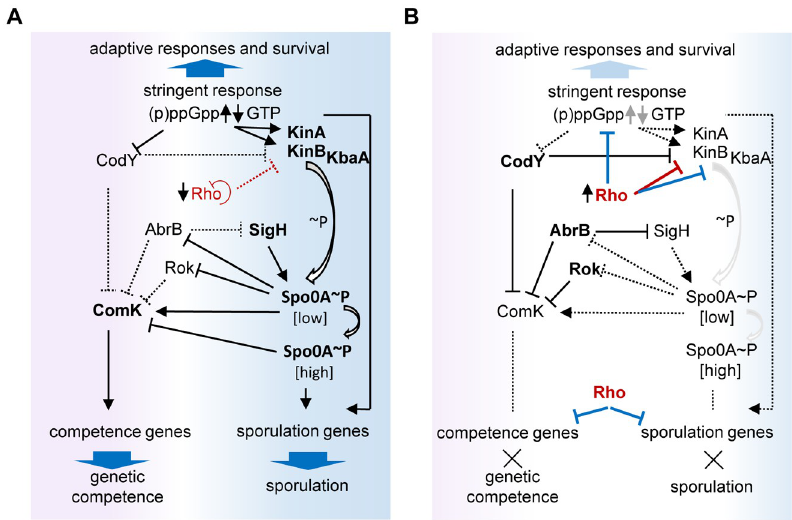
Fig 10. Tentative model integrating the termination factor Rho into the regulatory networks controlling the adaptation to stationary phase and the programs of genetic competence and sporulation in B . subtilis . For simplicity, only the key elements relevant to this study are shown, and the discussion of the regulatory activities of CodY and AbrB is limited to the comK gene. The arrowhead lines and bar-headed lines indicate positive and negative regulation, respectively. Solid and dashed headed lines indicate strong and weakened regulation, respectively, and the dashed lines without extremities stand for the loss of positive regulation. Red and blue bar-headed lines depict the Rho- mediated negative regulatory events identified previously (red) and in this study (blue). ( A ) In B . subtilis cells grown under starvation conditions, the increased (p)ppGpp synthesis linked to the activation of stringent response leads to lowering of GTP levels, thus decreasing the activity of CodY and stimulating the expression of the kinA and kinB genes, which are under positive stringent control [112]. The major sensor protein kinases KinA and KinB initiate transfer of the phosphoryl groups to Spo0A. KbaA protein stimulates KinB activity. The gradual increase in Spo0A * P activates expression of comK directly and indirectly by relieving the Rok- and AbrB-mediated repression of comK . By repressing AbrB, Spo0A~P activates the expression of sigH , thus creating a positive feed-back loop of autoregulation [37,79].When concentration of Spo0A~P reaches a high threshold level, it represses comK and activates expression of early sporulation genes. Synthesis of (p)ppGpp is necessary throughout the entire sporulation pathway [126]. In starving cells, Rho levels decrease due to the negative autoregulation [72] and some unknown regulatory circuits. Lowering of the Rho levels decreases the efficiency of the Rho-controlled transcription terminators thus activating, directly and indirectly, transcription of a set of genes and ncRNAs involved in adaptation to stationary phase. In particular, the lowering of Rho weakens the activity of the kinB intragenic Rho-dependent transcription terminator; as a result, the intensified read-through at the terminator stimulates synthesis of the full-length kinB transcript and consequently the activity of Spo0A~P [26]. ( B ) Counteracting the natural decrease of Rho levels by rho over-expression alters the normal progression to stationary phase as depicted. Stabilization of the intracellular levels of Rho in the stationary Rho + cells improves the Rho-dependent transcription termination and consequently alters the expression of the Rho-controlled genes and ncRNAs. A high Rho inhibits read-through at the intragenic transcription terminators of kinB and the newly identified Rho target kbaA gene thus decreasing the full-gene transcription of kinB and kbaA . A decreased flux of the phosphate alters the Spo0A~P-mediated inhibition of AbrB and thus disrupts its positive autoregulatory loop. As a result, Spo0A~P does not reach the threshold levels necessary neither for the de-repression of comk , nor for the efficient activation of early sporulation genes. The increase in Rho levels reinforces a still unknown mechanism by which Rho modulates the synthesis of (p)ppGpp and regulates the activation of stringent response. Altering the balance between p(p)ppGpp and GTP levels leads to an increased repression of comK by CodY and a weak activation of the positively-regulated stringent genes kinA and kinB , which additionally contributes to decreasing Spo0A~P activity. In addition, the analysis of the Rho + strain pinpoints the existence of yet non-identified targets of Rho-mediated regulation among the competence and sporulation genes. Overall, the increased control of Rho over its multiple targets provokes the loss of competence and sporulation in Rho +